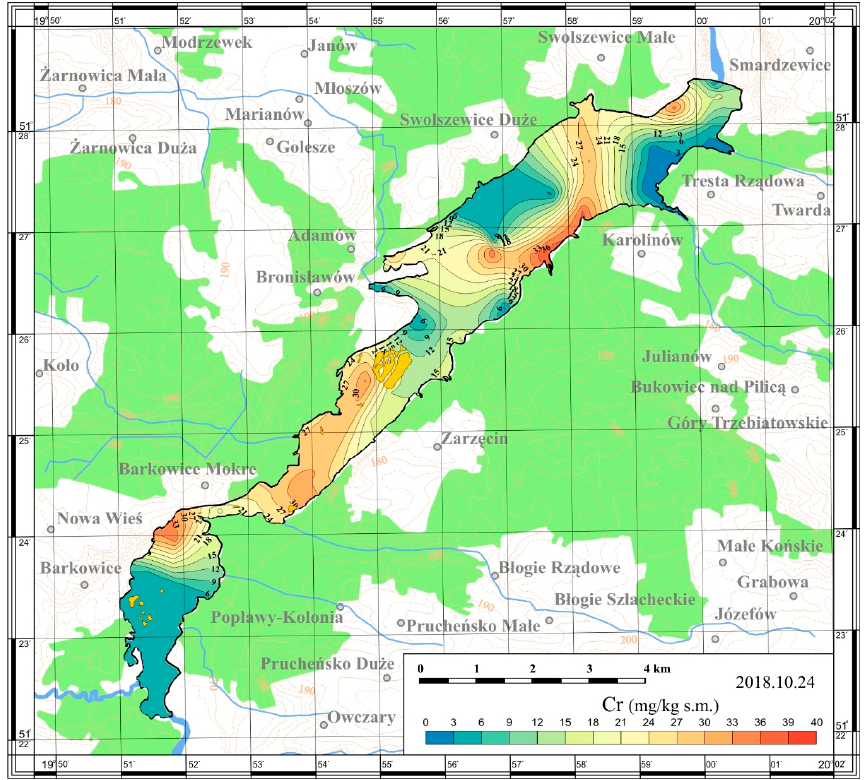
Figure 11. Spatial distribution of chromium in bottom sediments of the Sulejów Reservoir.